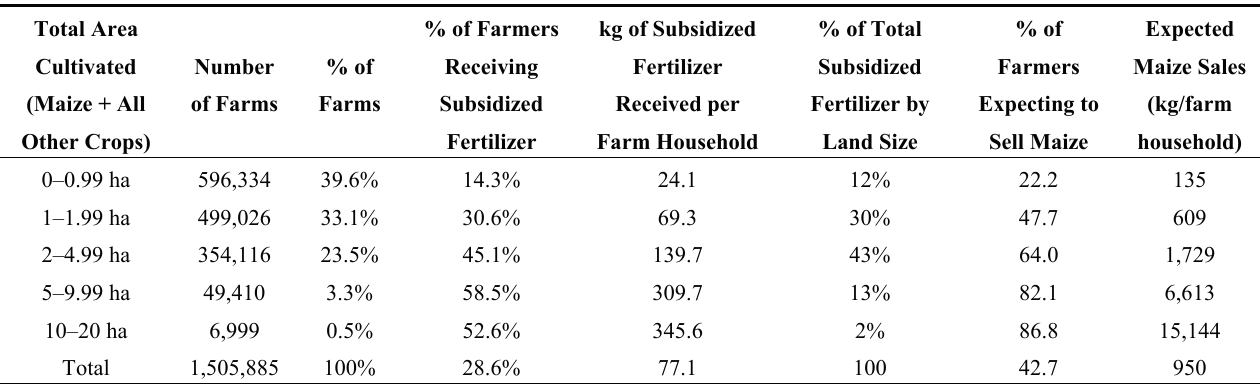
Table 1. FISP fertilizer received (2010/11 crop season) and expected maize sales, 2011, by farm size category. Source: MACO/CSO Crop Forecast Survey, 2010/11. Reproduced from Jayne et al. 2011